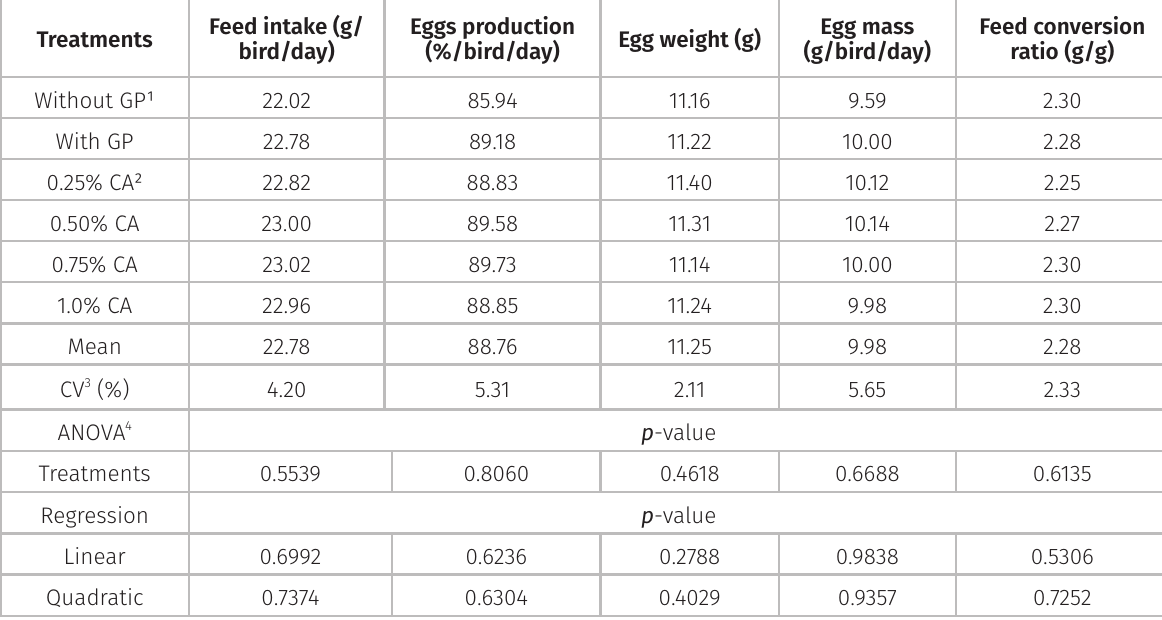
Table II. Performance of Japanese quails fed diets supplemented with calcium anacardate.